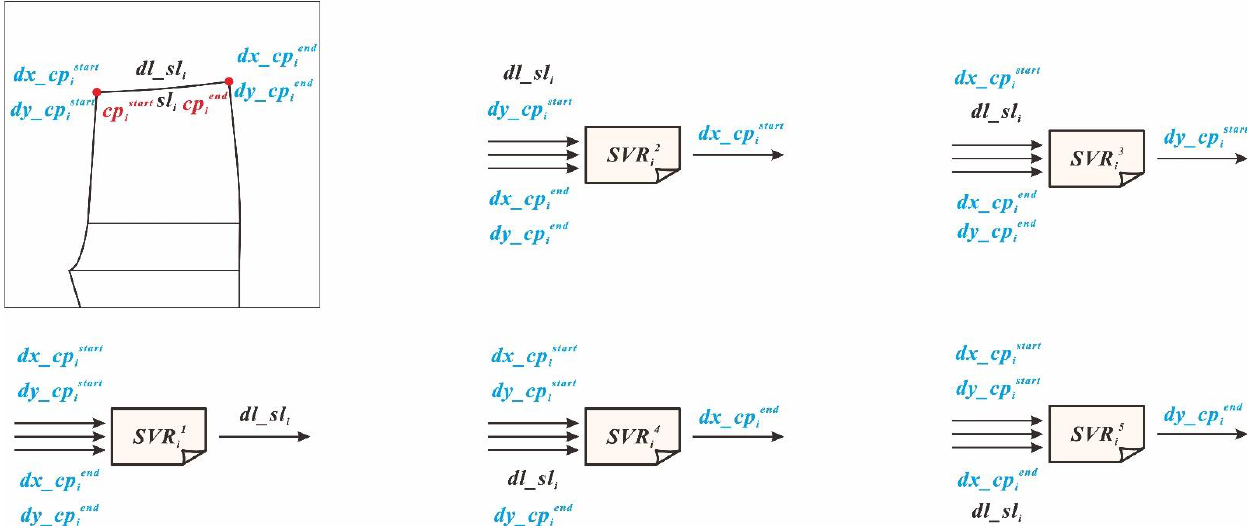
Figure 4. The SVR models for the structural line 𝑠𝑙 𝑖